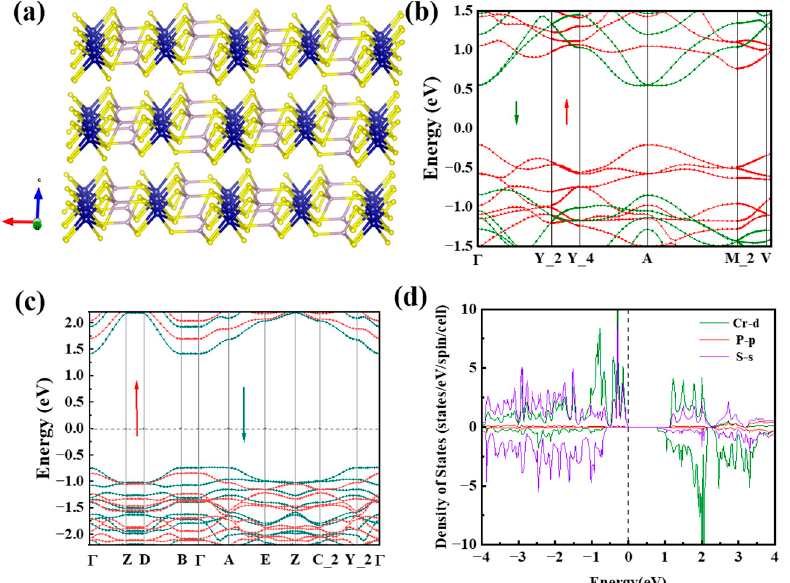
Figure 2. ( a ) Structure of CrPS 4 (The arrows represent the three coordinate axes of the crystallographic coordinate system); ( b , c ) electronic band structures of the bulk and monolayer CrPS 4 materials calculated by the HSE06 function (The red arrow denotes spin-up bands, while the green arrow represents spin-down bands in the energy band structure.); ( d ) DOS of the bulk CrPS 4 . Using the LPE method, few-layer CrPS 4 nanoflakes were exfoliated simply and effec- The obtained few-layer CrPS 4 nanoflakes were then dripped onto the D-shaped fiber to form an SA device. To investigate the nonlinear optical properties of the CrPS 4 -SA, a laser (1550 nm, 100 fs, 8.05 MHz) was employed, as shown in Figure 4 inset. Equation (1) only considers the case of single-photon absorption, and the nonlinear saturated absorption curve of CrPS 4 -SA was obtained after fitting